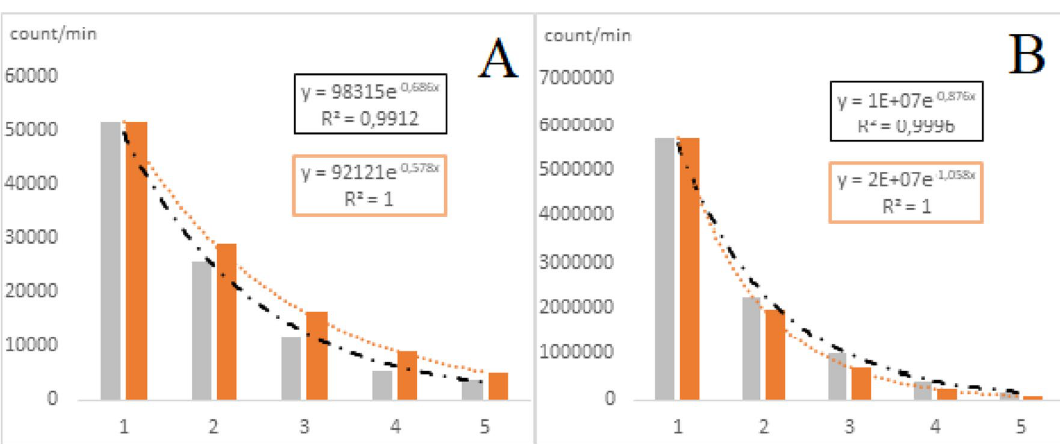
Figure 5. Examples of measured and estimated exponential models from ( A ) Control group, ( B ) Biotic stress group with high correlation coefficient (R 2 = 0.9912 and R 2 = 0.9996, respectively). Higher initial biophoton emission intensities indicate more intensive decay of biophoton emission intensity in